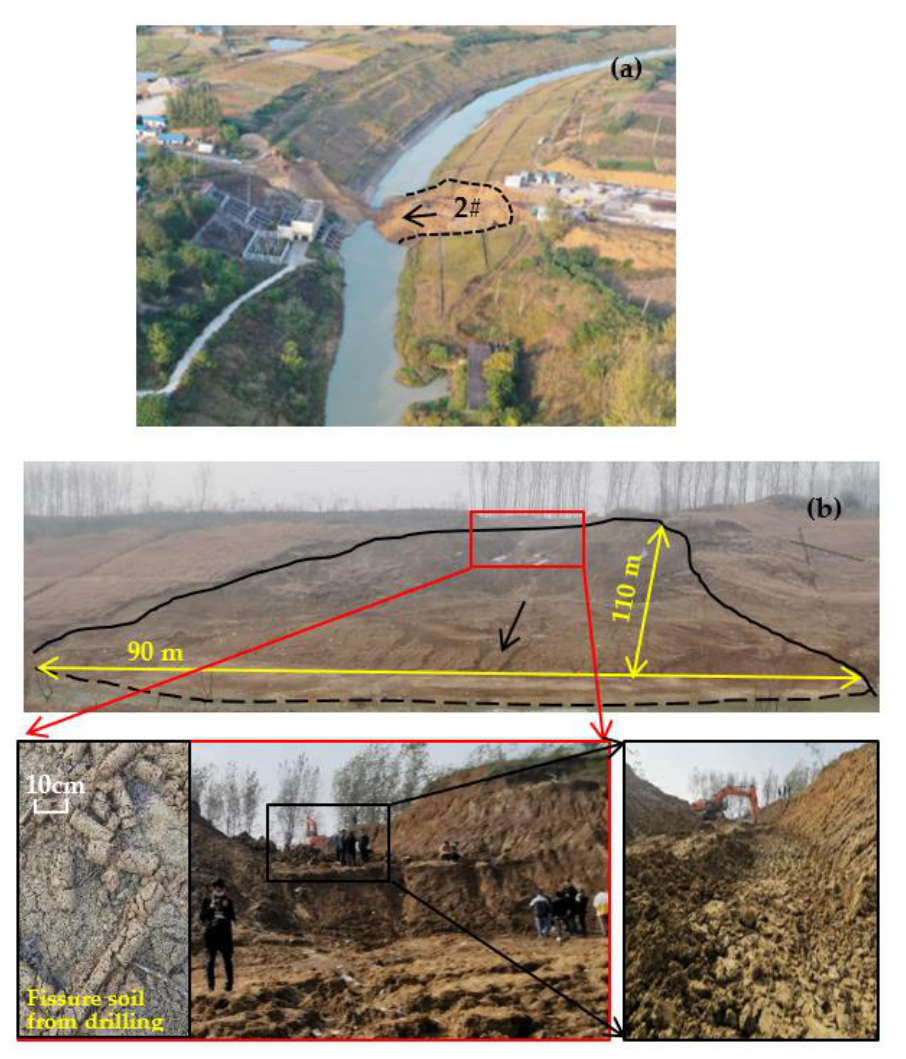
Figure 1. An expansive soil landslide in the Pishihang irrigation district, Anhui, China. ( a ) The 2# landslide happened in late 2019; ( b ) sampling on the landslide.